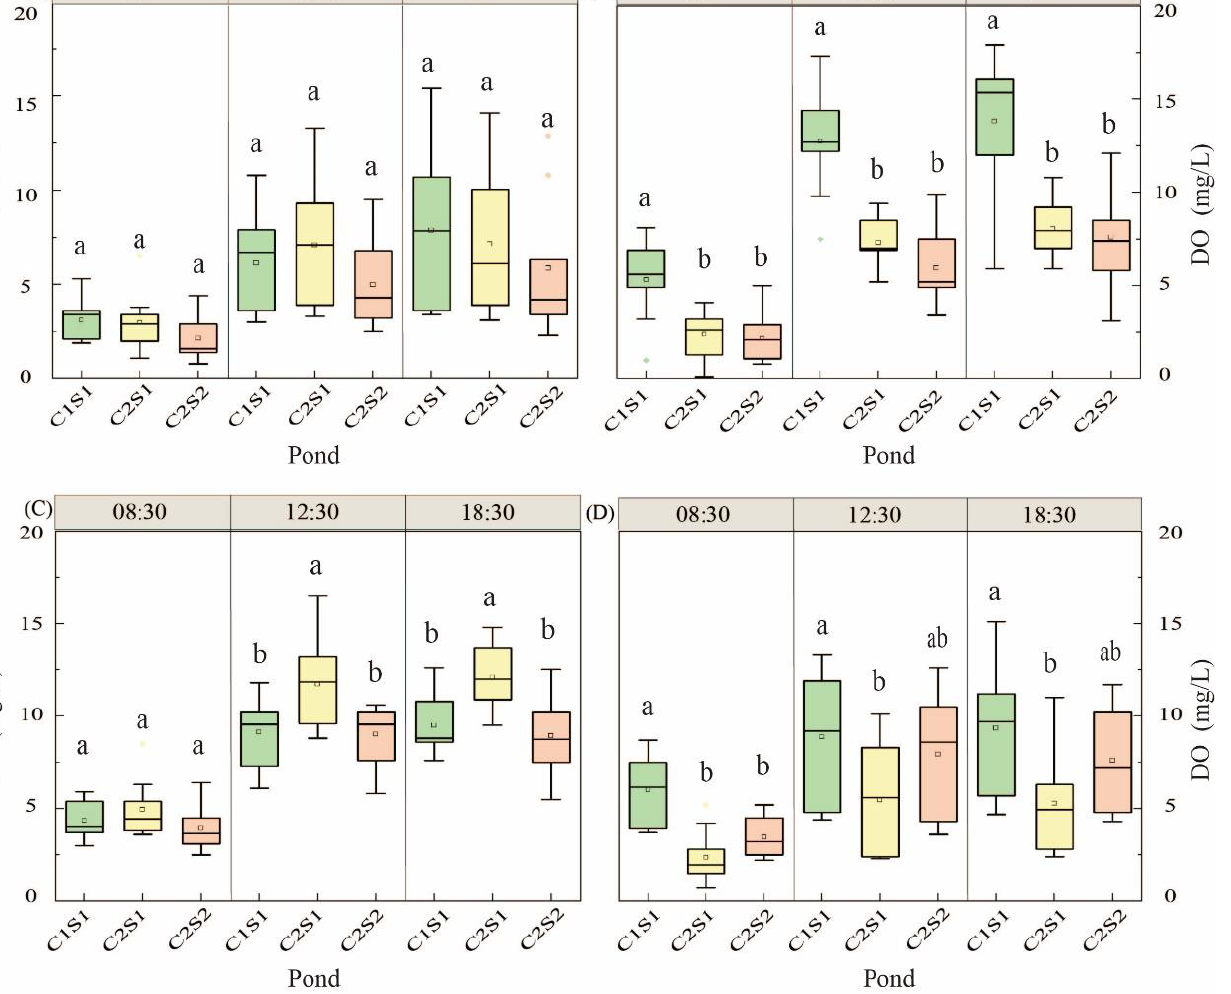
Figure 3. Monthly variation of water dissolved oxygen (DO) in different ponds. ( A ) July; ( B ) August; ( C ) September; ( D ) October. Values with the same letter are not significantly different (LSD post hoc test).